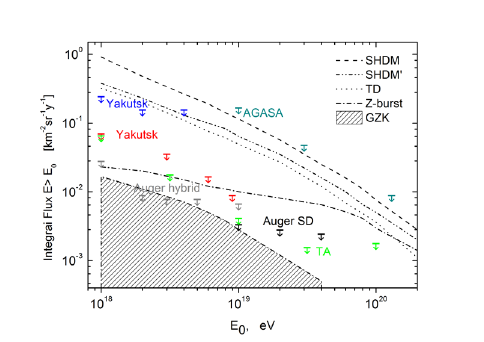
Figure 2. Dependence of X max from the classification parameter Figure 4. Dependence of the muon fraction on depth of maxi- Q (200) - EAS Cherenkov light flux density at a distance of 200 m from the shower axis. Data obtained in 1973-2014 zenith angles θ 1 = 18 ◦ , θ 2 = 38 ◦ and θ 3 = 58 ◦ . The fits are made